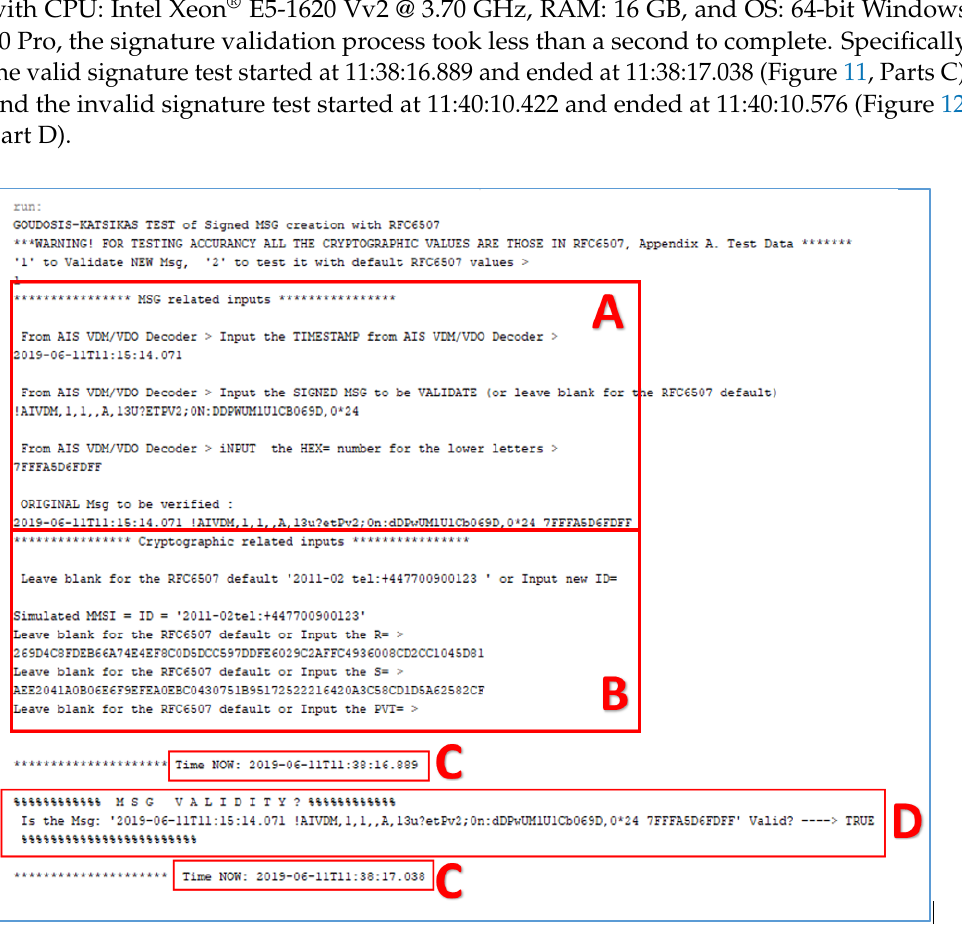
Figure 11. Authentic and valid SecAIS message: Message-related inputs ( A ); Cryptographic-related inputs ( B ); Start and end timestamps of validity check ( C ); Result of validity check ( D